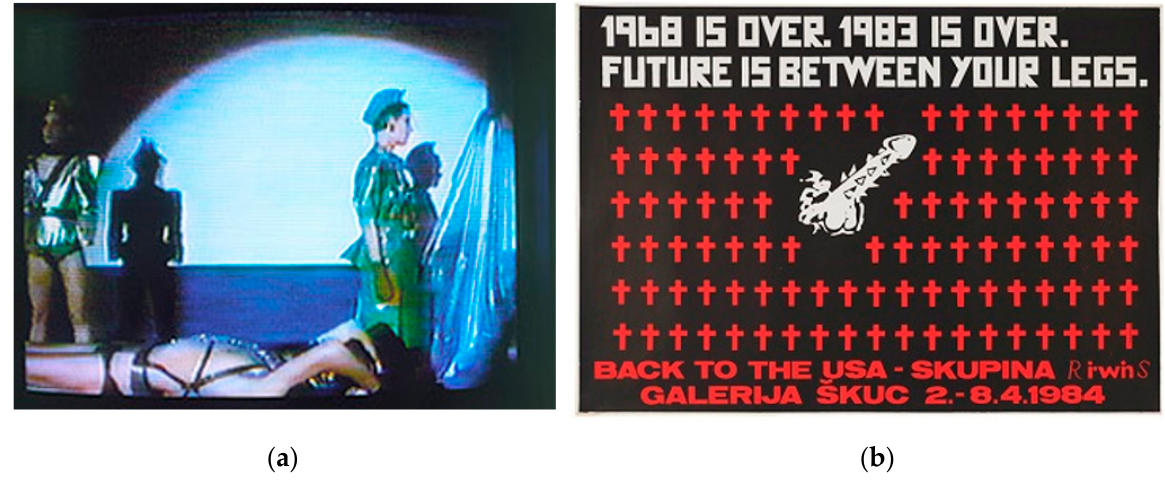
Figure 8. ( a ) Borghesia, Lustmörder , 1984, Cankarjev dom, Ljubljana. ( b ) Dušan Mandi ć , “1968 is over. 1983 is over. Future is between your legs”, poster. Visual used for the poster of IRWIN’s exhibition “Back to the USA”, Galerija Škuc, Ljubljana, 1984.